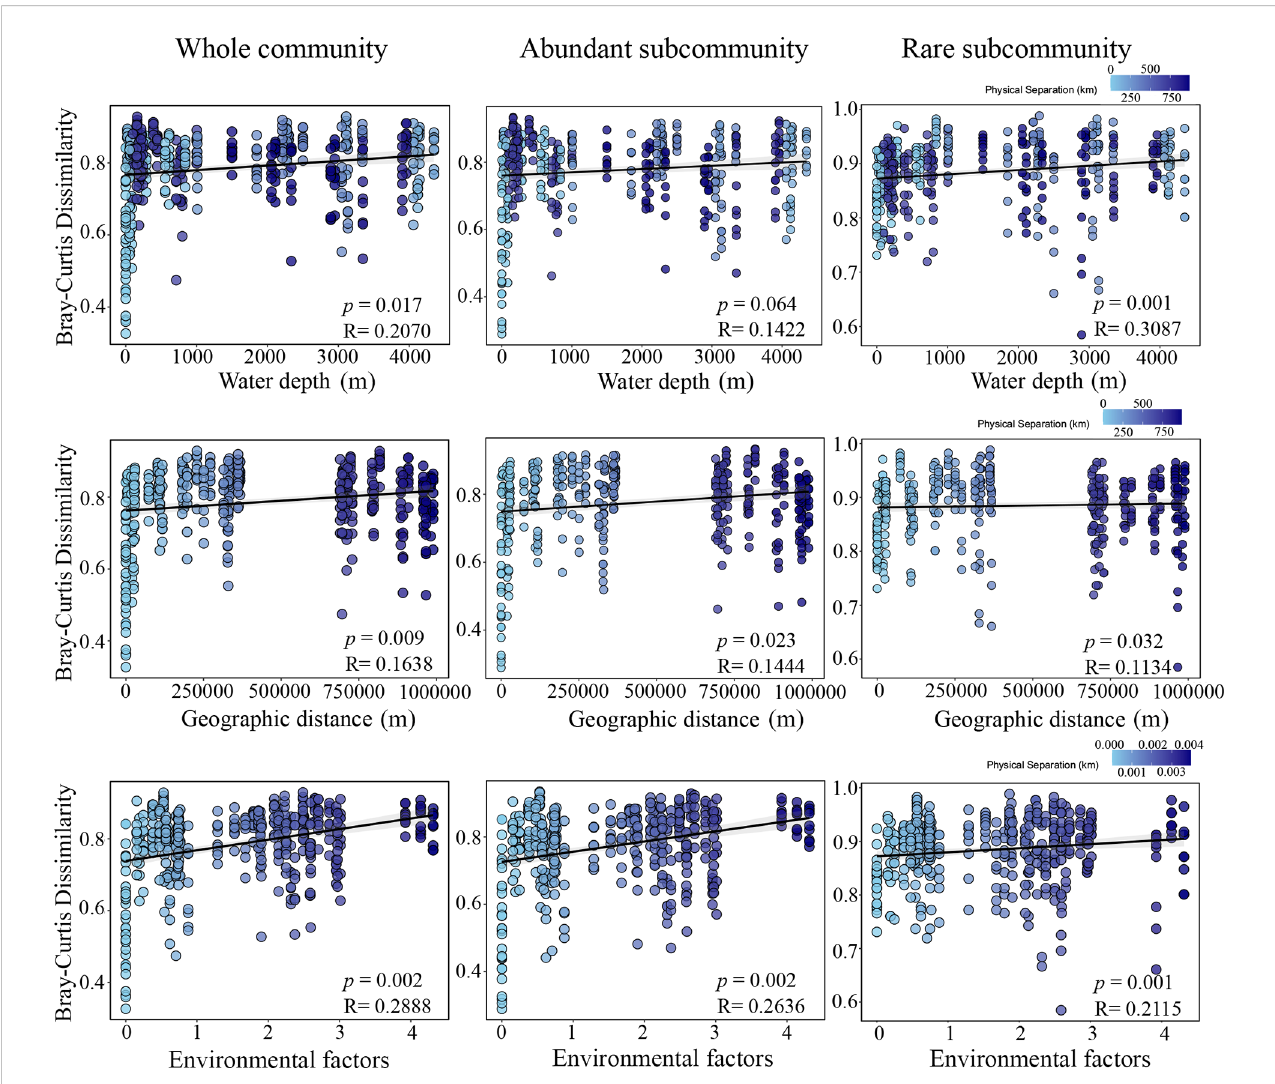
FIGURE 5 Mantel test results between Bray-Curtis dissimilarity of whole community, abundant and rare subcommunities with water depth, geographic distance and environmental factors (chlorophyll a and pheophytin